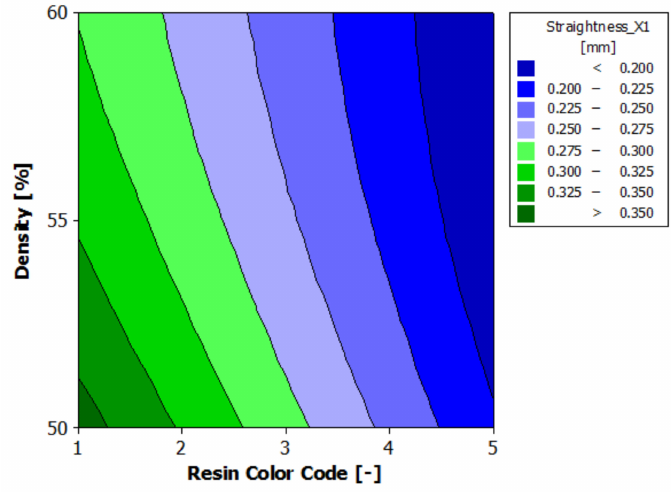
Figure 17. Contours of estimated response surface for Straightness_X1. Contour X2